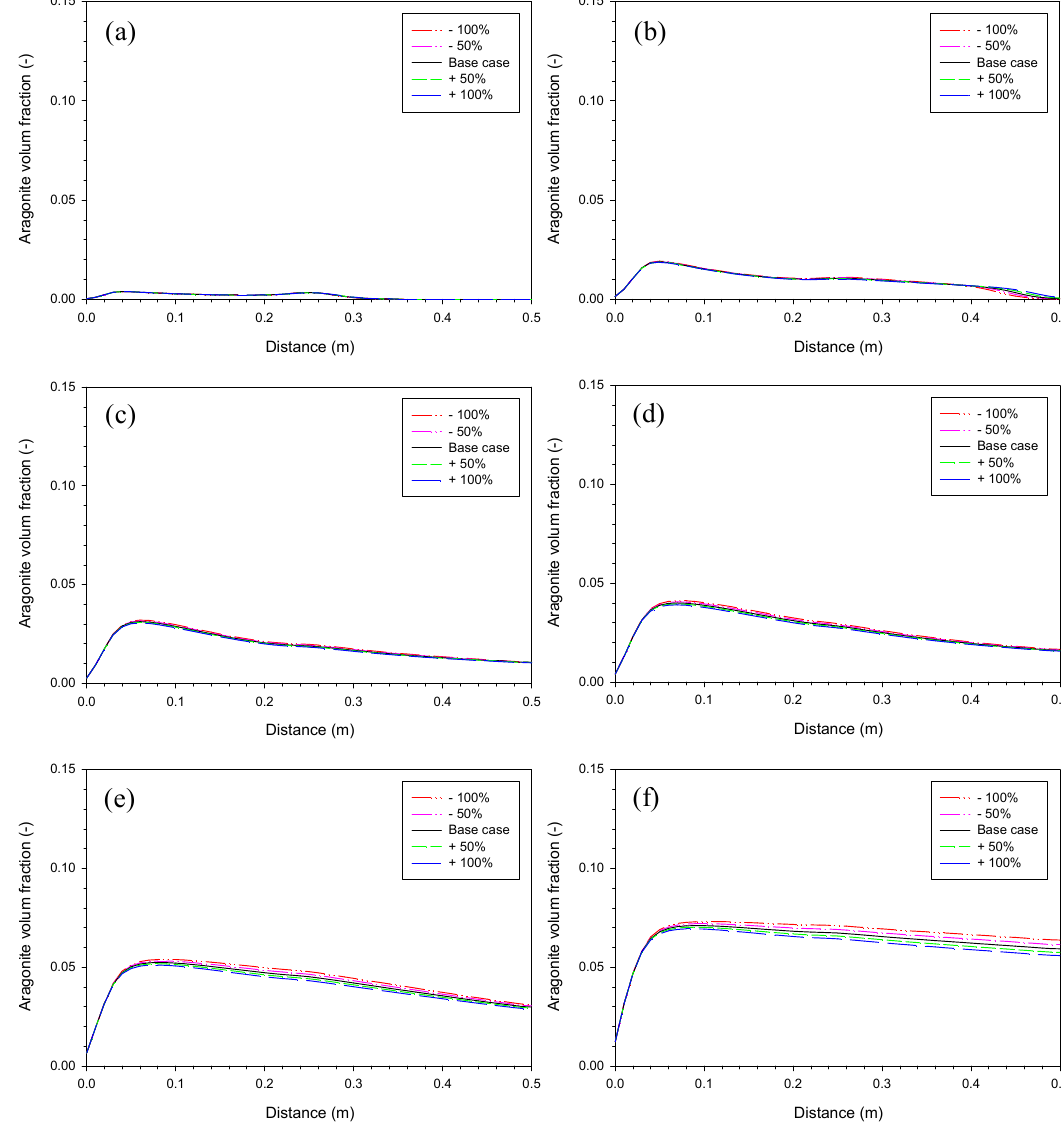
Figure 10. Sensitivity analysis of α 2 (proportionality constant for Fe 2 (OH) 2 CO 3 (s)). Aragonite volume fraction on ( a ) Day 4, ( b ) Day 25, ( c ) Day 54, ( d ) Day 87, ( e ) Day 164, and ( f ) Day 410 with value of the base case, +/−50% and +/−100%.